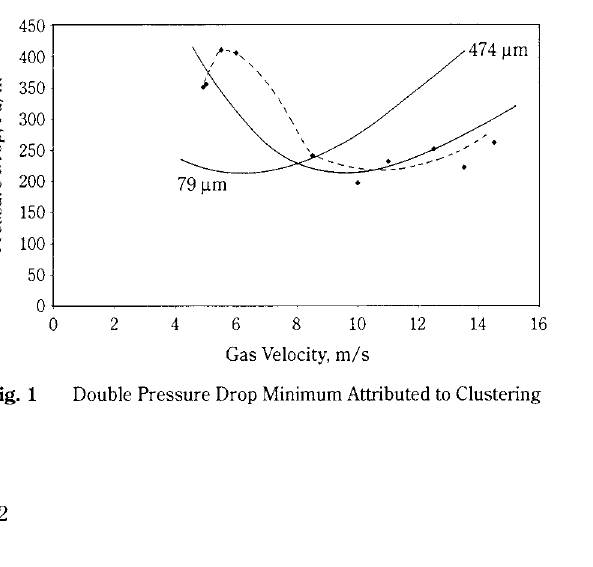
Double Pressure Drop Minimum Attributed to